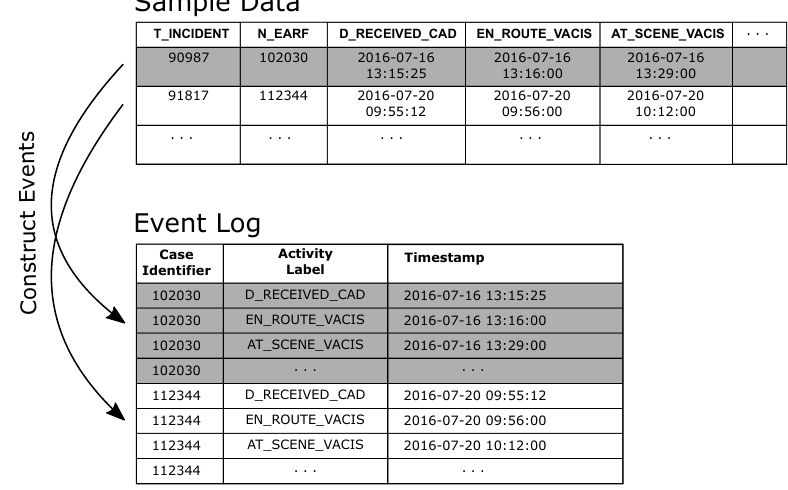
Figure 8. Event Log creation from sample